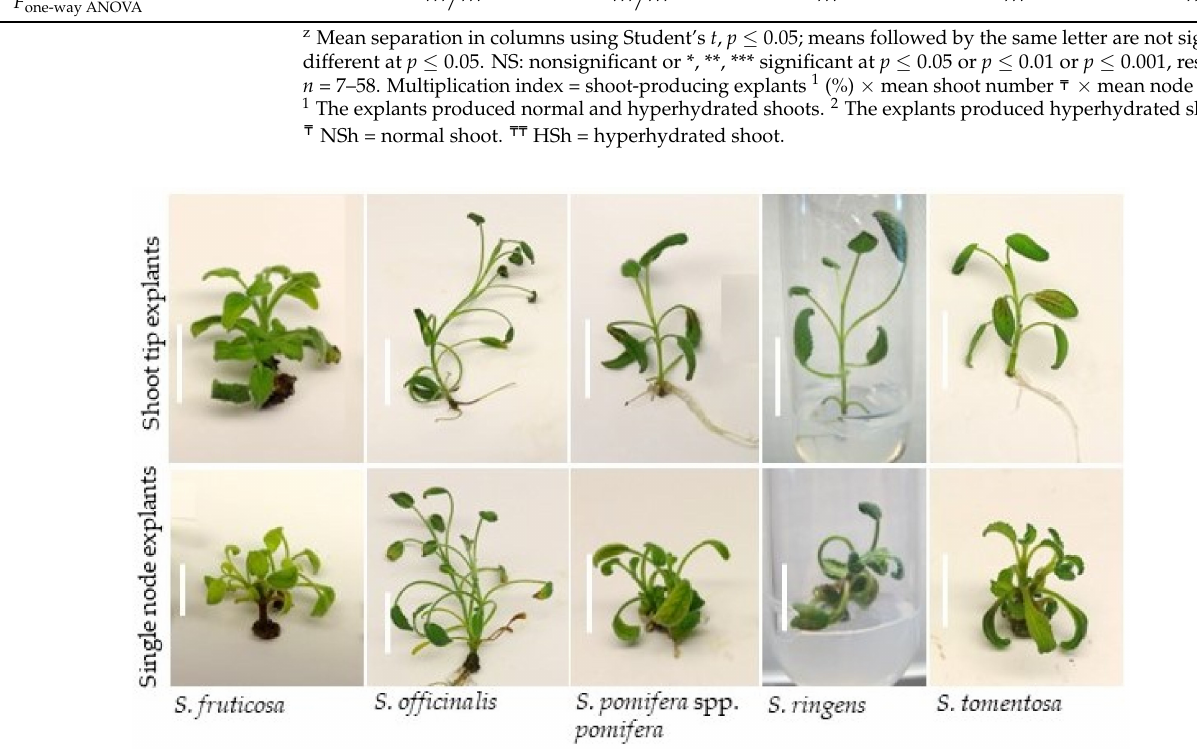
Figure 3. Typical responses of shoot tip and single node explants excised from in vitro seedlings of Salvia spp., during the in vitro establishment stage on hormone-free MS medium. Size bars = 1.0 cm.